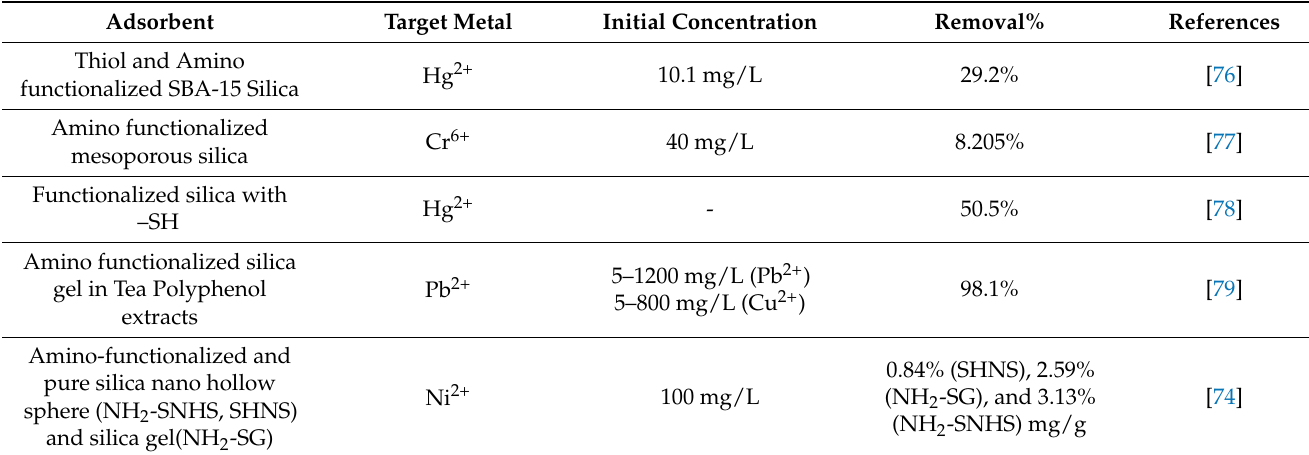
Table 4. Silica based materials for the adsorption of heavy